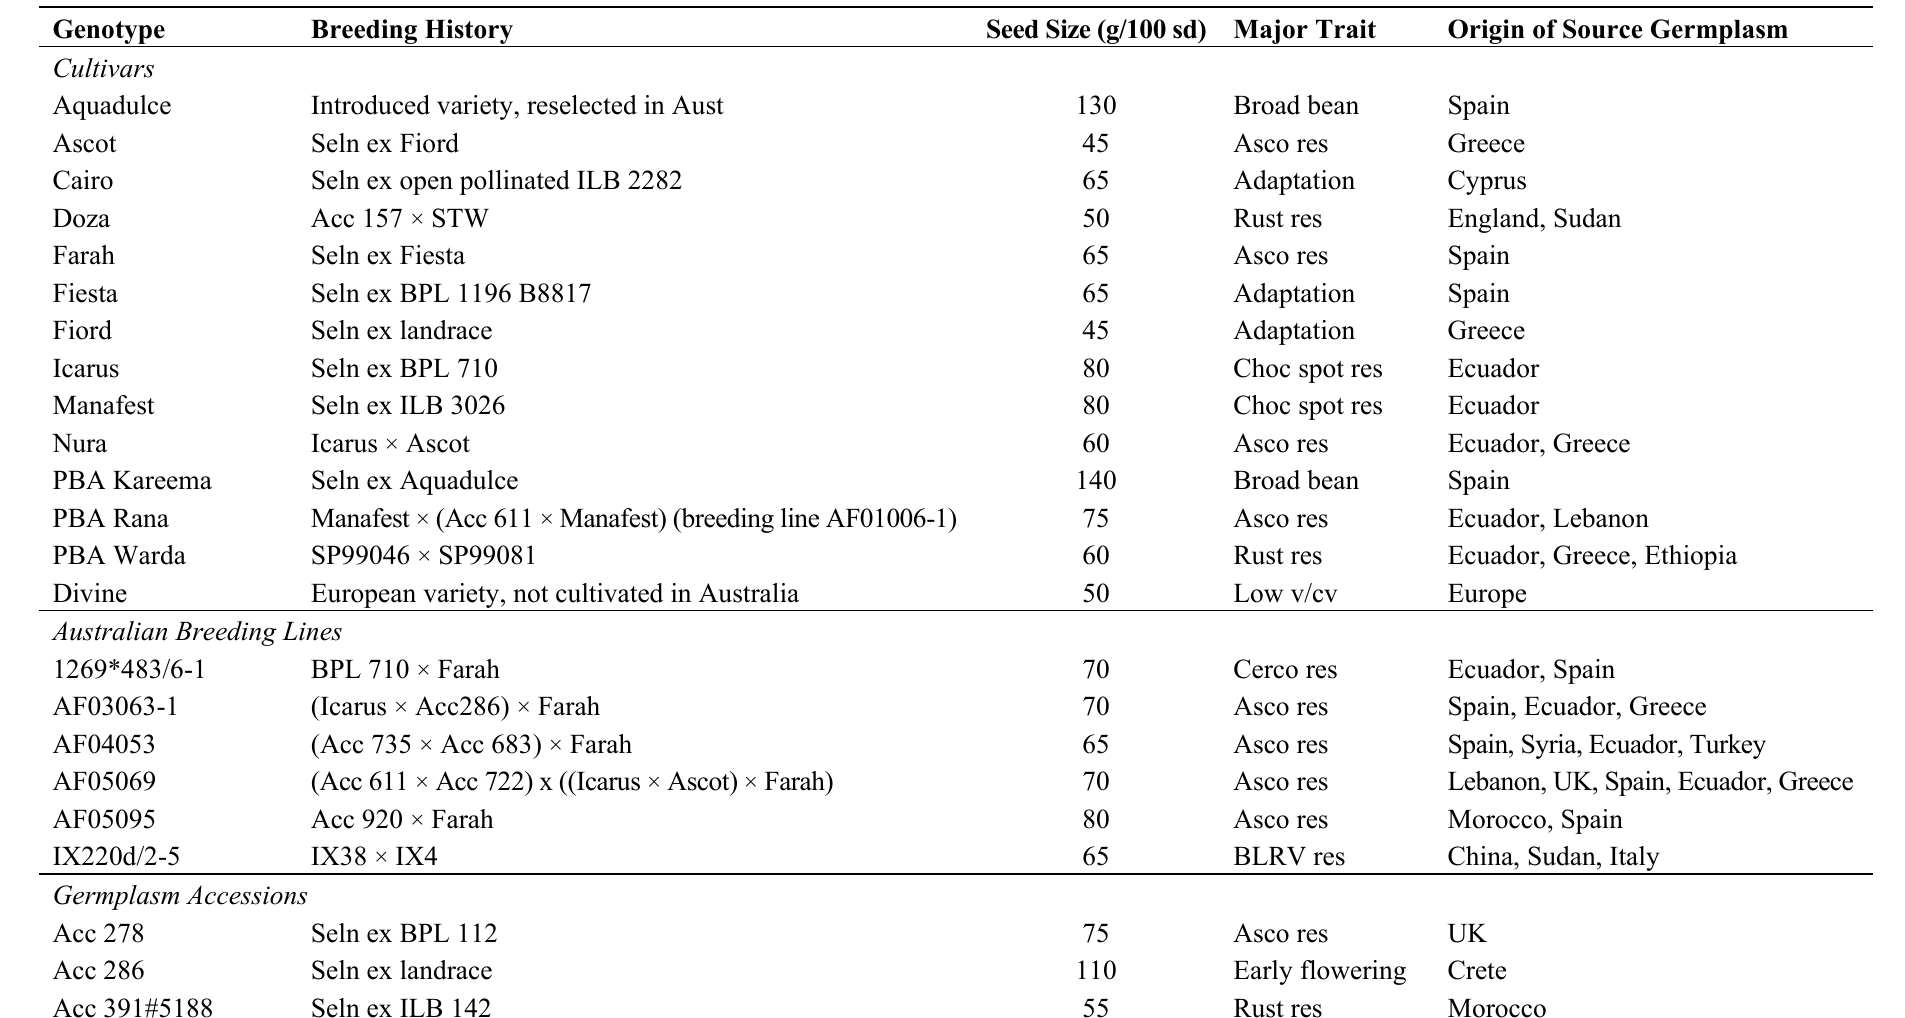
Table 1. Details of breeding history, major characteristic traits and origin of the cultivars and germplasm evaluated in the diversity study. The countries listed in the origin of the source germplasm are listed in decreasing order of contribution to the pedigree of the test genotype. The origin of source germplasm reflects the original source, when known, rather than the location of the